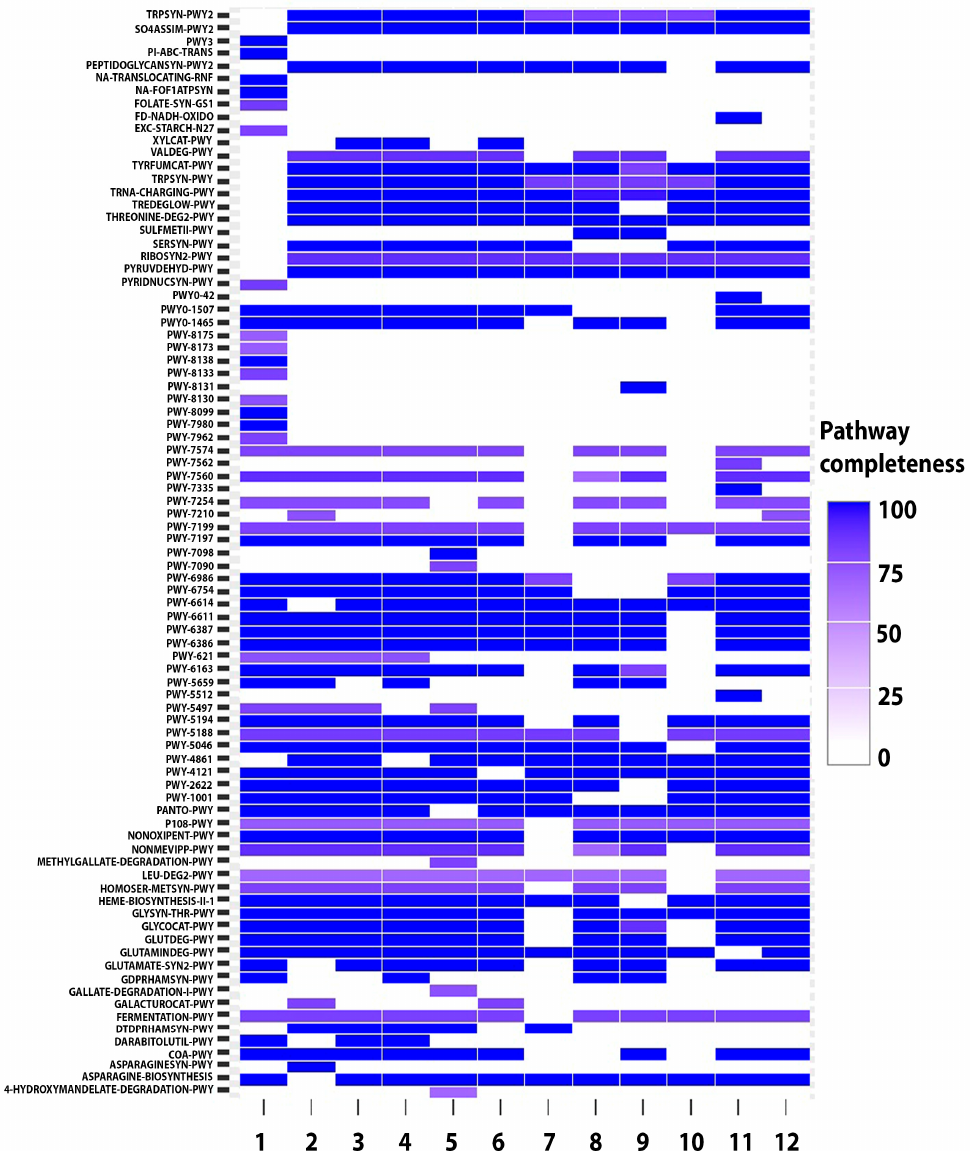
Figure 10. Strain-specific metabolic pathways in P. distincta and P. arctica A 37-1-1 T (pathway signatures are depicted in the corresponding Supplementary Table S5): 1— P. distincta 16-SW-7 (GCA_005877035.1; seawater); 2— P. distincta ANT 505 (GCA_000212655.3; seawater); 3— P. distincta